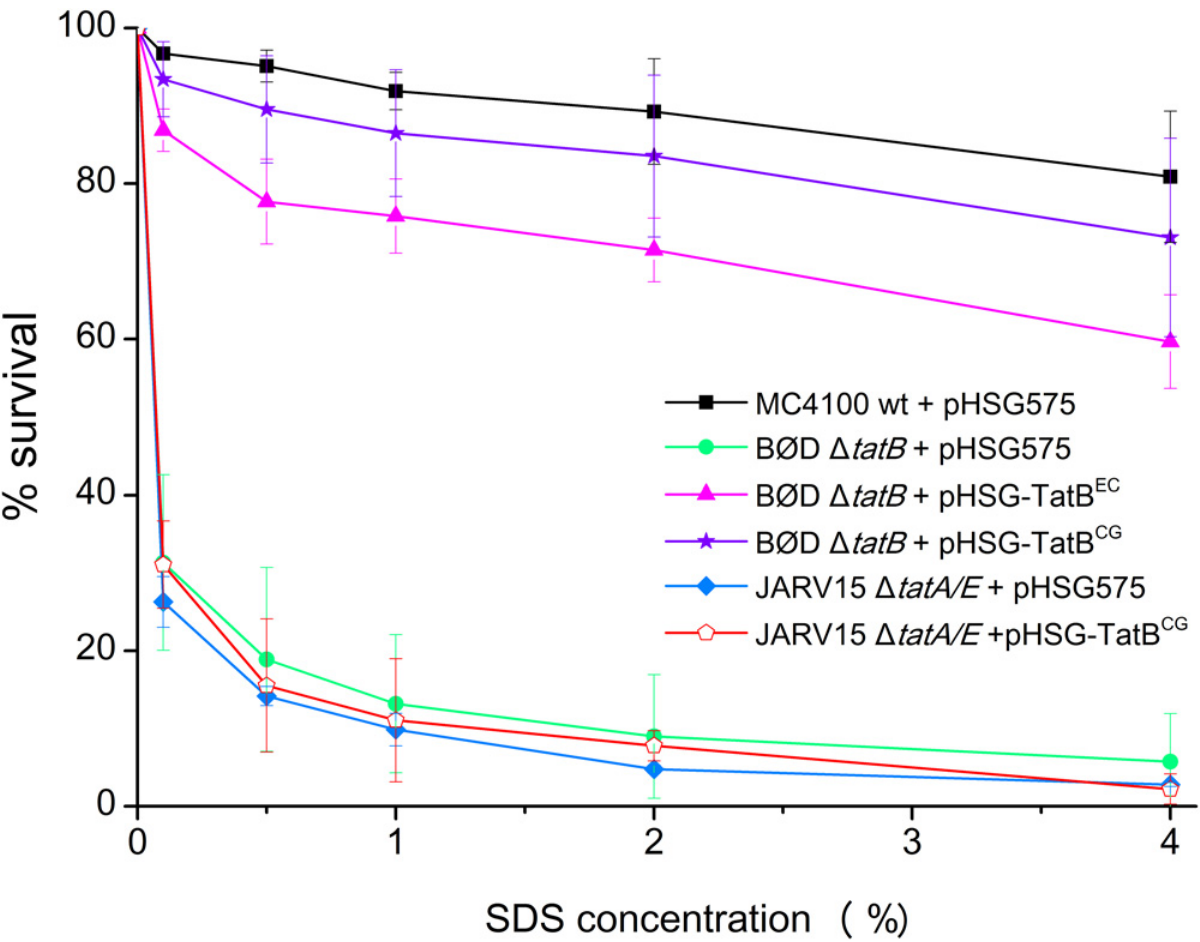
Fig 6. SDS sensitivity of E . coli tat mutant strains expressing the C . glutamicum TatB protein from plasmid pHSG-TatB CG . MC4100 (wild-type) containing the empty vector pHSG575 (black squares), B Ø D ( Δ tatB ) containing pHSG575 (green circles), B Ø D containing pHSG-TatB EC (pink triangles), B Ø D containing pHSG-TatB CG (purple asterisks), JARV15 ( Δ tatA/E ) containing pHSG575 (blue diamonds), and JARV15 containing pHSG-TatB CG (red open pentagons) were analyzed for SDS sensitivity using the assay described by Ize et al. [40]. The cells were grown for 3 h in LB medium containing 100 μ M IPTG in the presence of various SDS concentrations as outlined in the Material and Methods section. 100% survival is defined as the optical density of each strain after 3 h growth in LB medium without SDS. The experiments were performed in triplicate using biologically independent replicates and the respective standard deviations are